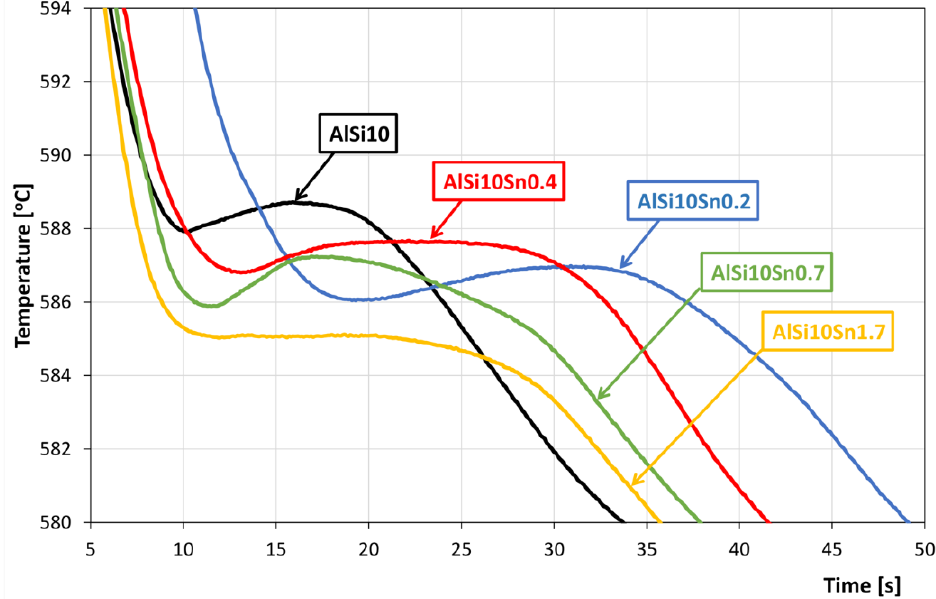
Figure 2. Part of AlSi10Sn alloy’s cooling curve diagram in terms of the onset of solidification of α -Al solid solution.